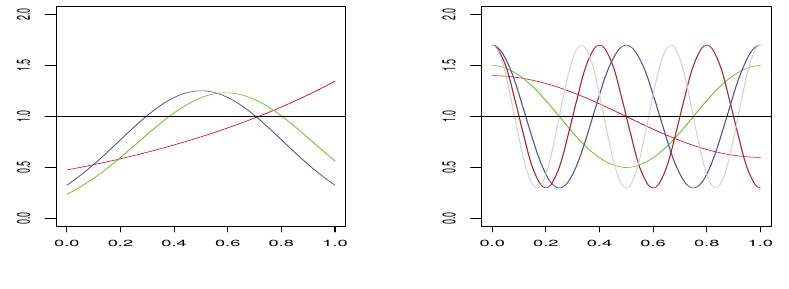
Figure 4. g 1 (left plot) and g 2 (right plot) alternatives chosen for simulation study.